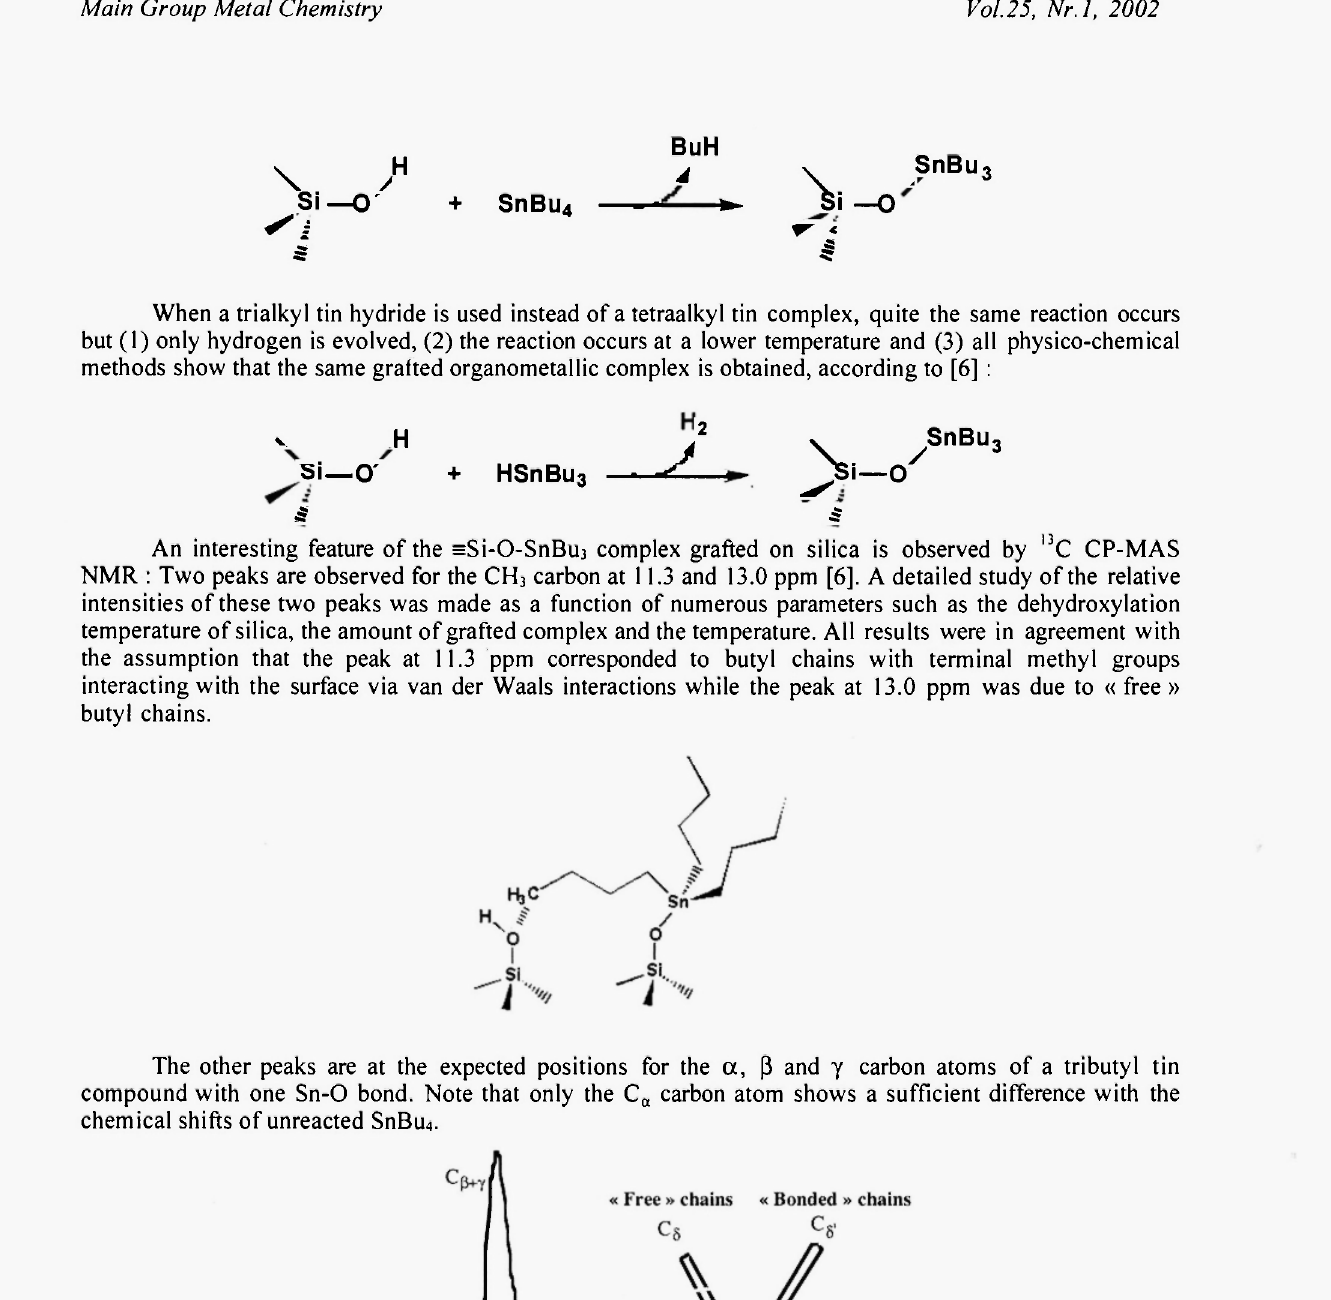
Figure 2 :' 3 C CP-MAS NMR spectrum of sSi-0-SnBu 3 grafted on